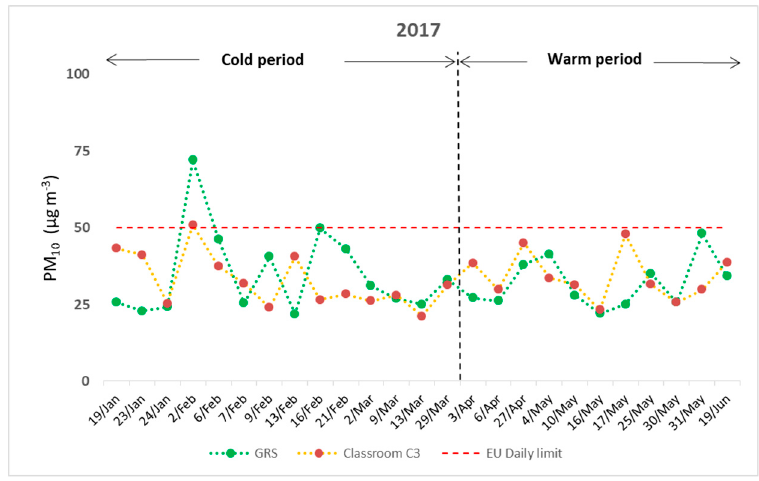
Figure 2. Mean daily concentrations of PM 10 indoors and outdoors during the experimental period.